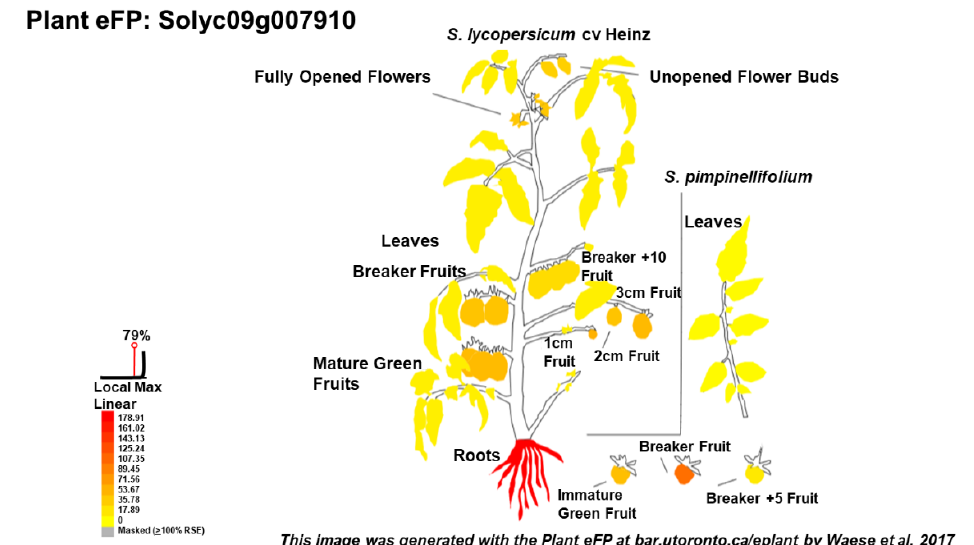
Figure 3. Example of an electronic Fluorescent Pictograph (eFP) visualization using the PAL gene Solyc09g007910 as query. The gene is highly expressed in the roots. The image was generated with the Plant eFP at bar.utoronto.ca/eplant [50]. Data are from [48] and are RPKM-normalized.